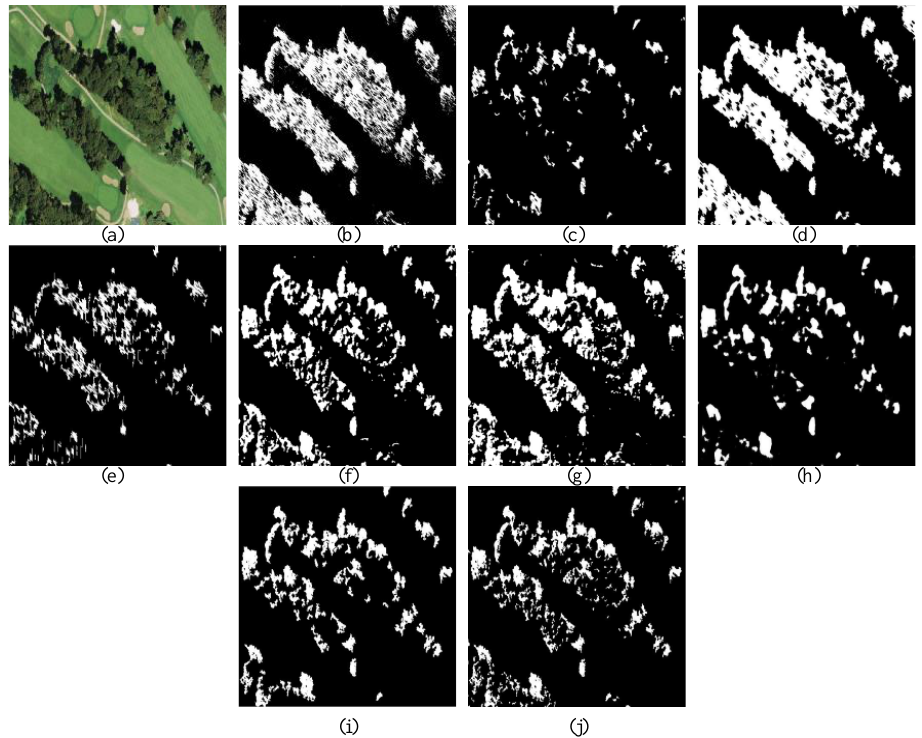
Figure 12. Vegetation shadow detection in San Francisco district : ( a ) original image; ( b ) SRHI; ( c ) NB; ( d ) HTD; ( e ) C1C2C3; ( f ) U-Net method; ( g ) Segnet method; ( h ) BDRAR method; ( i ) DLA-PSO method; ( j ) ground truth.